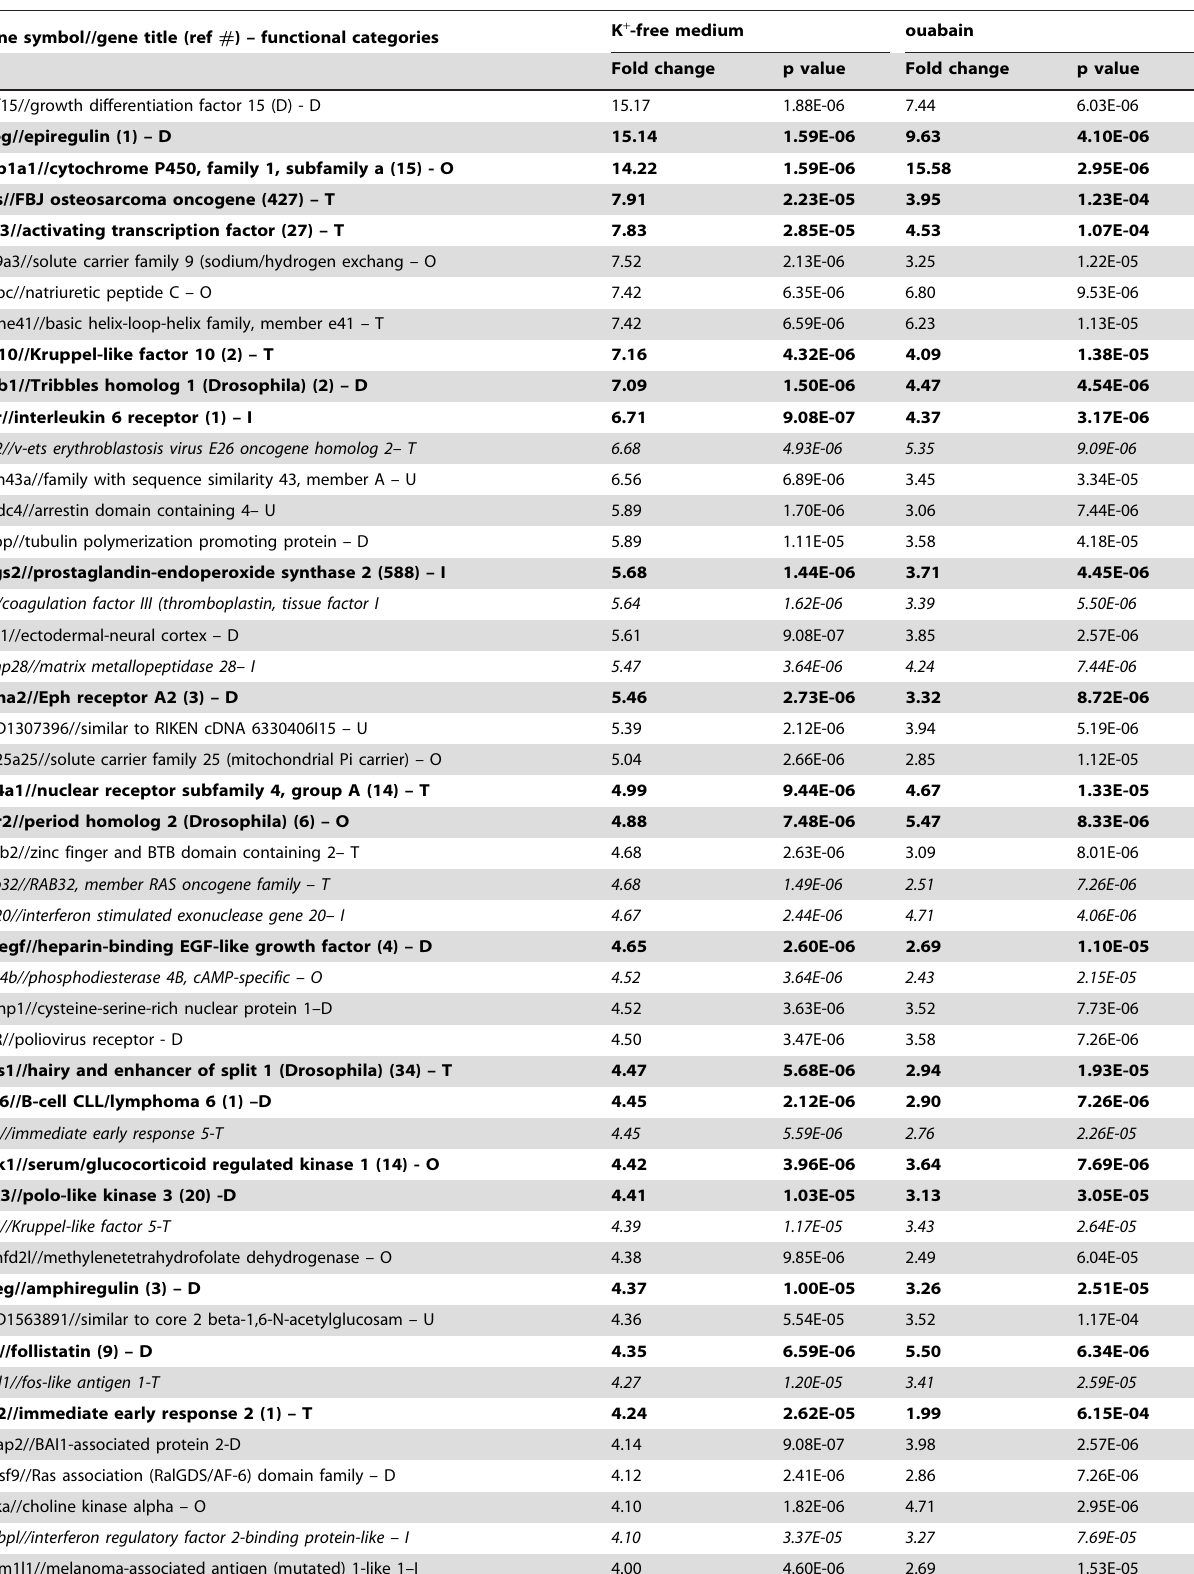
Table 1. Genes whose expression was increased in RASMC subjected to Na + ,K + -ATPase inhibition.